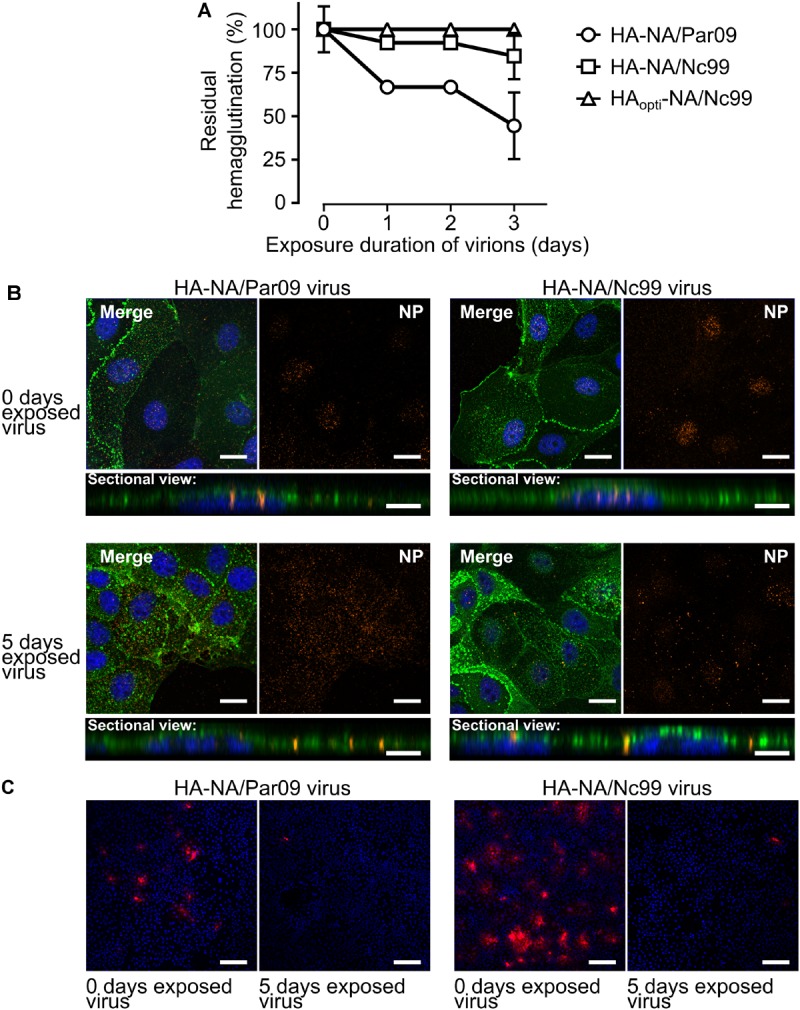
The HA of virus particles is still able to bind its cellular receptor but cannot trigger membrane fusion after being exposed. (A) Evolution of the residual hemagglutination titer (%) during exposure of reassortant viruses in saline water at 35°C. Vertical lines represent the standard deviation (N = 3). (B) Confocal immunofluorescence microscopy (×40) of (A) MDCK cells 2 h after infection by either the HA-NA/Par09 virus (left) or the HA-NA/Nc99 virus (right), which have been exposed (bottom) or not (top) for 5 days to saline water (35 g.L-1 NaCl) at 35°C. Signal of the influenza NP immunolabeling is shown in orange. WGA labeling signal at the cell membrane is shown in green and the nucleus labeling with Hoescht dye is shown in blue. For each condition a merge of all channels (top left), the NP immunolabeling acquisition channel only (top right) or a Z-stack of sectional views at a distance of 0.42 μM (bottom) are shown. (C) MDCK cells (×10 magnification) 20 min after infection with both HA-NA/Par09 and HA-NA/Nc99 viruses previously labeled with the R18 fluorophore at a self-quenched concentration. R18 dequenching signal due to the fusion of the viral envelope with the endosomal membrane is shown in red. Scale bars represent 20 μm (B, merged and NP views), 10 μm (B, sectional views), and 100 μm (C).